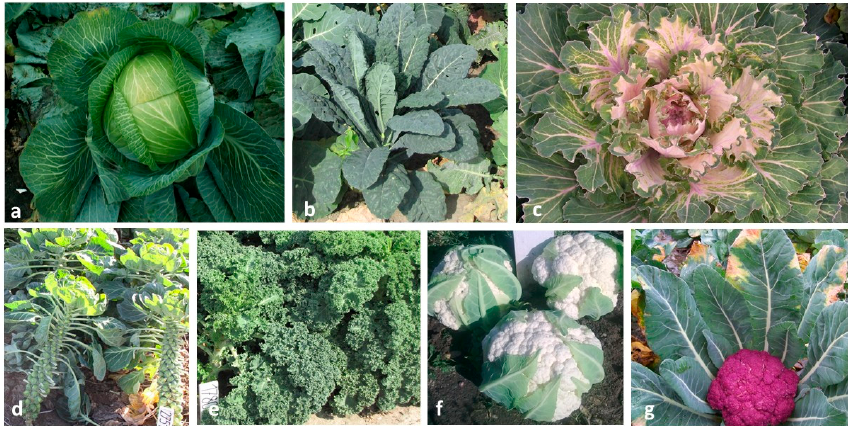
Figure 1. The diversity of Brassica oleracea vegetable crops. ( a ) Head cabbage ( b ) Leafy cabbage plants ( c ) Ornamental leafy cabbage; ( d ) Brussels sprouts; ( e ) Kale; ( f ) Cauliflower; ( g ) Purple cauliflower.